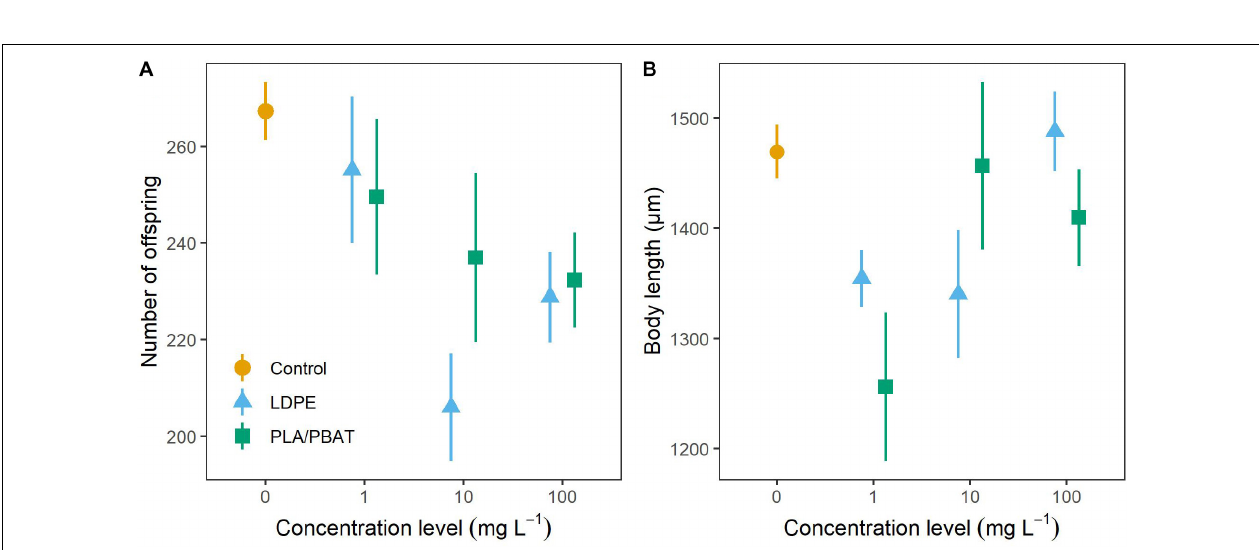
FIGURE 3 | (A) Number of offspring and (B) body length of C. elegans as a function of concentration and plastic type compared to the control group. Data are presented as means ± SE.